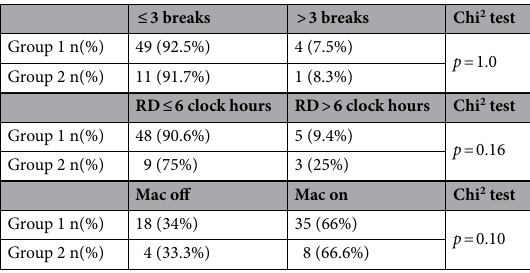
Table 1. Clinical characteristics of RD in group 1 and